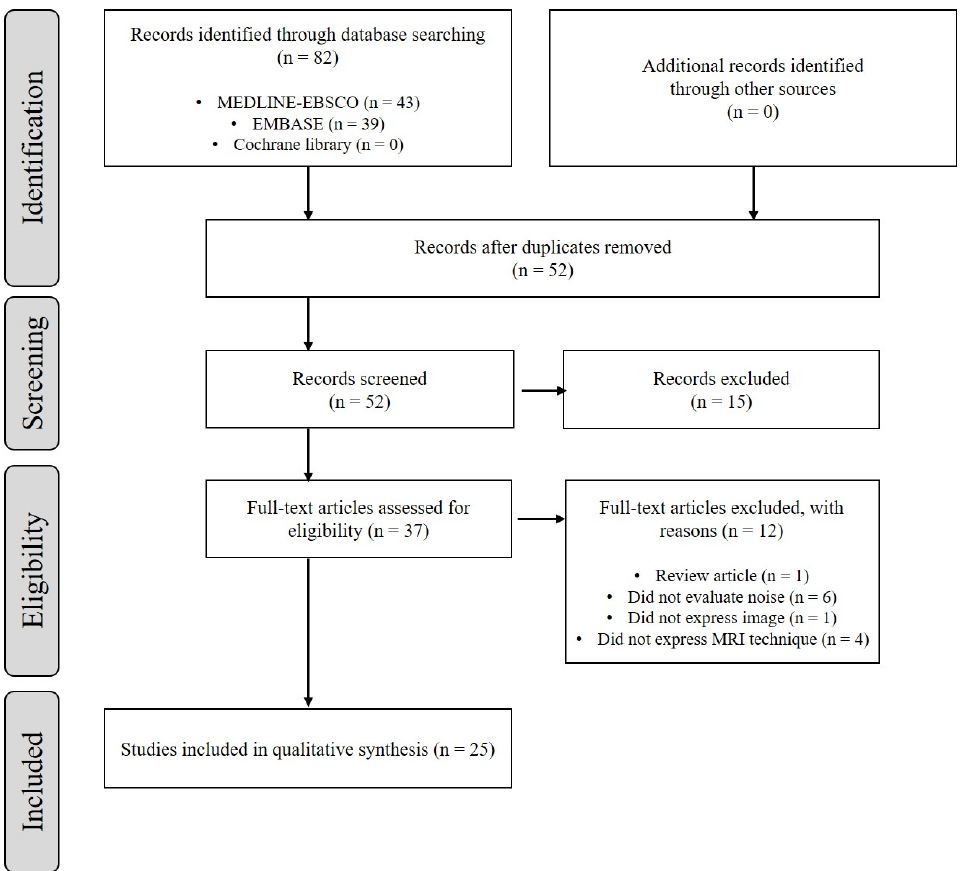
Figure 2. Flowchart of the method used for selection of publications. Through searches of three search databases, 52 papers were identified based on our criteria after removing duplicate articles.